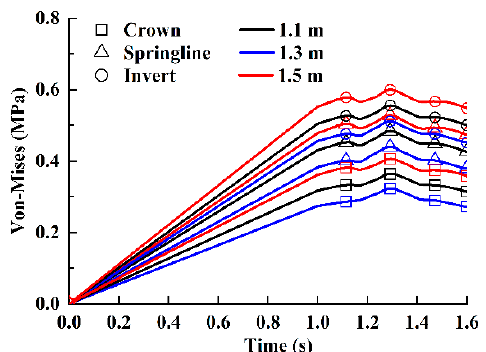
Figure 9. Time history curves of the Von-Mises stresses of the different buried depth of pipe under traffic load.